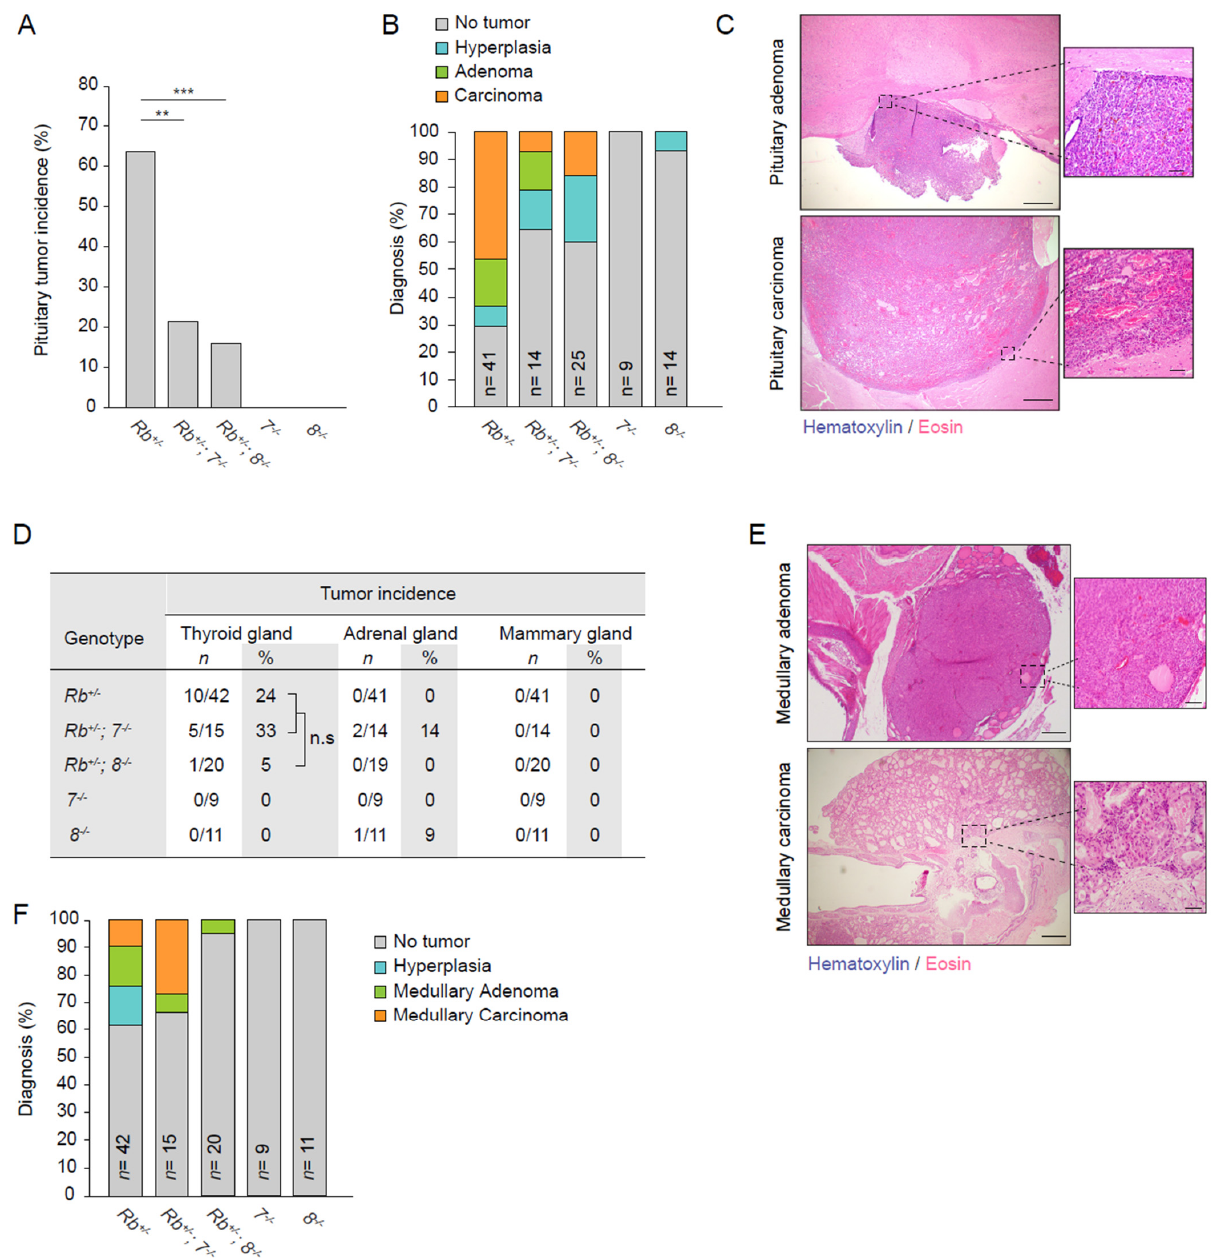
Figure 3. E2F7 and − 8 promote tumorigenesis in pituitary glands with RB loss ( A ) Pituitary tumor incidence (%) in 14 months old mice from the indicated genotypes. Data collected from Rb + / − n = 41; Rb + / − , 7 − / − n = 14; Rb + / − , 8 − / − n = 25; 7 − / − n = 9; 8 − / − n = 14. ( B ) Histological diagnoses of pituitary glands from ( A , C ) Representative images of histological features of pituitary tumors. Scale bars: left picture 500 µ m; right 50 µ m. ( D ) Microscopic tumor incidence of additional neuroendocrine glands from mice in ( A , E ) Representative images of histological features of thyroid tumors. Scale bars: left picture 500 µ m; right 50 µ m. ( F ). Histological diagnoses of thyroid tumors from ( E ) Data information: In ( A , D ); n.s not significant, ** p < 0.01, *** p < 0.001 (chi-square).